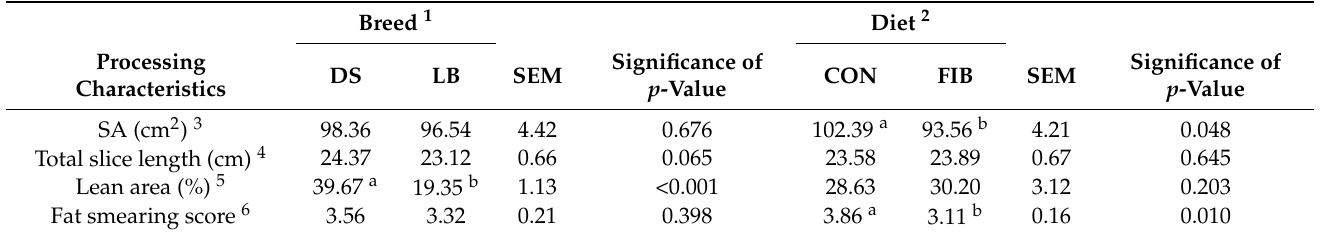
Table 2. Effect of breed and diet on the physical characteristics of bacon slices and fresh sausage.